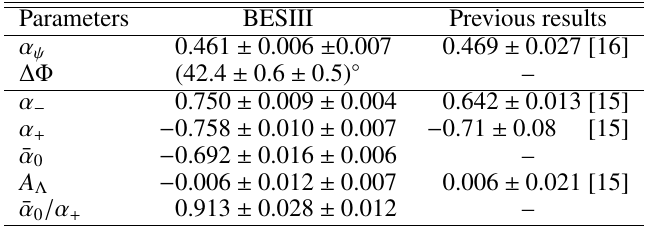
Table 1. Summary of the results: the J /ψ → Λ ¯ Λ angular distribution parameter α ψ , the phase ∆Φ , the asymmetry parameters for the Λ → p π − ( α − ), ¯ Λ → ¯ p π + ( α + ) and ¯ Λ → ¯ n π 0 (¯ α 0 ) decays, the CP asymmetry A Λ , and the ratio ¯ α 0 /α + .